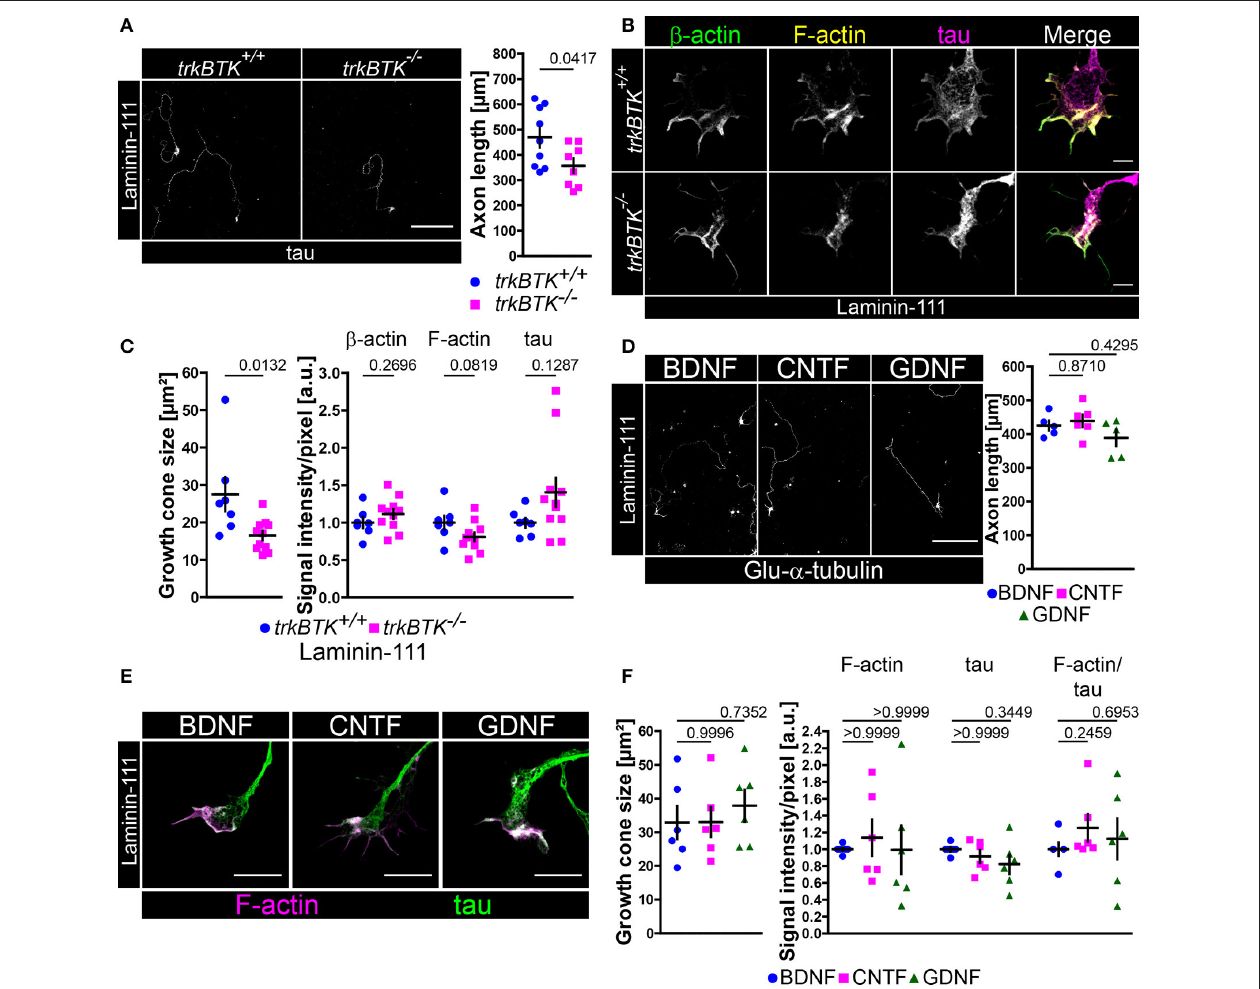
FIGURE 6 | On laminin-111 BDNF is dispensable for axon growth and F-actin assembly in growth cones. (A) Representative images of trkBTK + / + and trkBTK − / − motoneurons cultured on laminin-111 for 7 days in vitro and stained against tau (scale bar: 150 µ m). TrkB mutant motoneurons (357.2 ± 29.33 µ m, Q 2 363 µ m, n = 8, N = 579) grew shorter axons ( p = 0.0417) in comparison to wild type controls (468.8 ± 39.31 µ m, Q 2 454.9 µ m, n = 9, N = 615). (B) Representative images of axonal growth cones of trkBTK + / + and trkBTK − / − motoneurons cultured for 5 days in vitro on laminin-111 and stained against β -actin (green), F-actin (yellow), and tau (magenta) (scale bar: 5 µ m). (C) TrkBTK − / − motoneurons (16.55 ± 1.26 µ m 2 , Q 2 17.12 µ m 2 , n = 11, N = 178) developed significantly smaller growth cones ( p = 0.0132) than the corresponding controls (27.51 ± 4.58 µ m 2 , Q 2 25.06 µ m 2 , n = 7, N = 113). There were no significant alterations between both genotypes with respect to β -actin, F-actin and tau levels. (D) Representative images of wild type motoneurons cultured on laminin-111 for 7 days in vitro with BDNF, CNTF or GDNF and stained against tau (scale bar: 150 µ m). There was no difference in axonal elongation between each neurotrophic factor (BDNF 425.3 ± 14.93 µ m, Q 2 423.3 µ m, n = 5, N = 256; CNTF 439.0 ± 18.37 µ m, Q 2 439.9 µ m, n = 6, N = 258; GDNF 388.6 ± 24.47 µ m, Q 2 412.1 µ m, n = 5, N = 273; p(B-C) = 0.8710, p(B-G) = 0.4295). (E) Representative images of axonal growth cones of motoneurons cultured on laminin-111 for 5 days in vitro in the presence of BDNF, CNTF or GDNF and stained against F-actin (magenta) and tau (green) (scale bar: 5 µ m). (F) There was no significant difference in growth cone size between each condition (BDNF 32.83 ± 4.93 µ m 2 , Q 2 29.04 µ m 2 , n = 6, N = 165; CNTF 33.01 ± 4.41 µ m 2 , Q 2 30.96 µ m 2 , n = 6, N = 175; GDNF 37.85 ± 4.72 µ m 2 , Q 2 38.52 µ m 2 , n = 6, N = 172; p(B-C) = 0.9996, p(B-G) = 0.7352). Furthermore, F-actin (BDNF 1.00 ± 0.02, Q 2 1.00, IQR 0.04, n = 6, N = 165; CNTF 1.14 ± 0.22, Q 2 0.95, IQR 0.97, n = 6, N = 175; GDNF 0.99 ± 0.28, Q 2 0.79, IQR 1.02, n = 6, N = 172; p(B-C) > 0.9999, p(B-G) > 0.9999) and tau levels appeared not